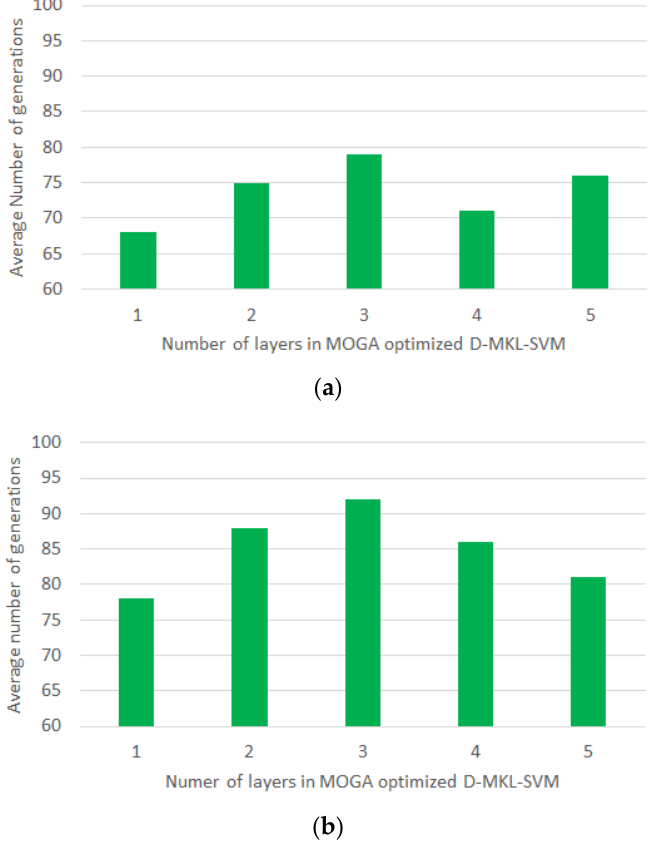
Figure 6. Average number of generations versus the number of layers in MOGA optimized D-MKL-SVM under 10-fold cross-validation: ( a ) driver drowsiness recognition and ( b ) driver stress recognition.